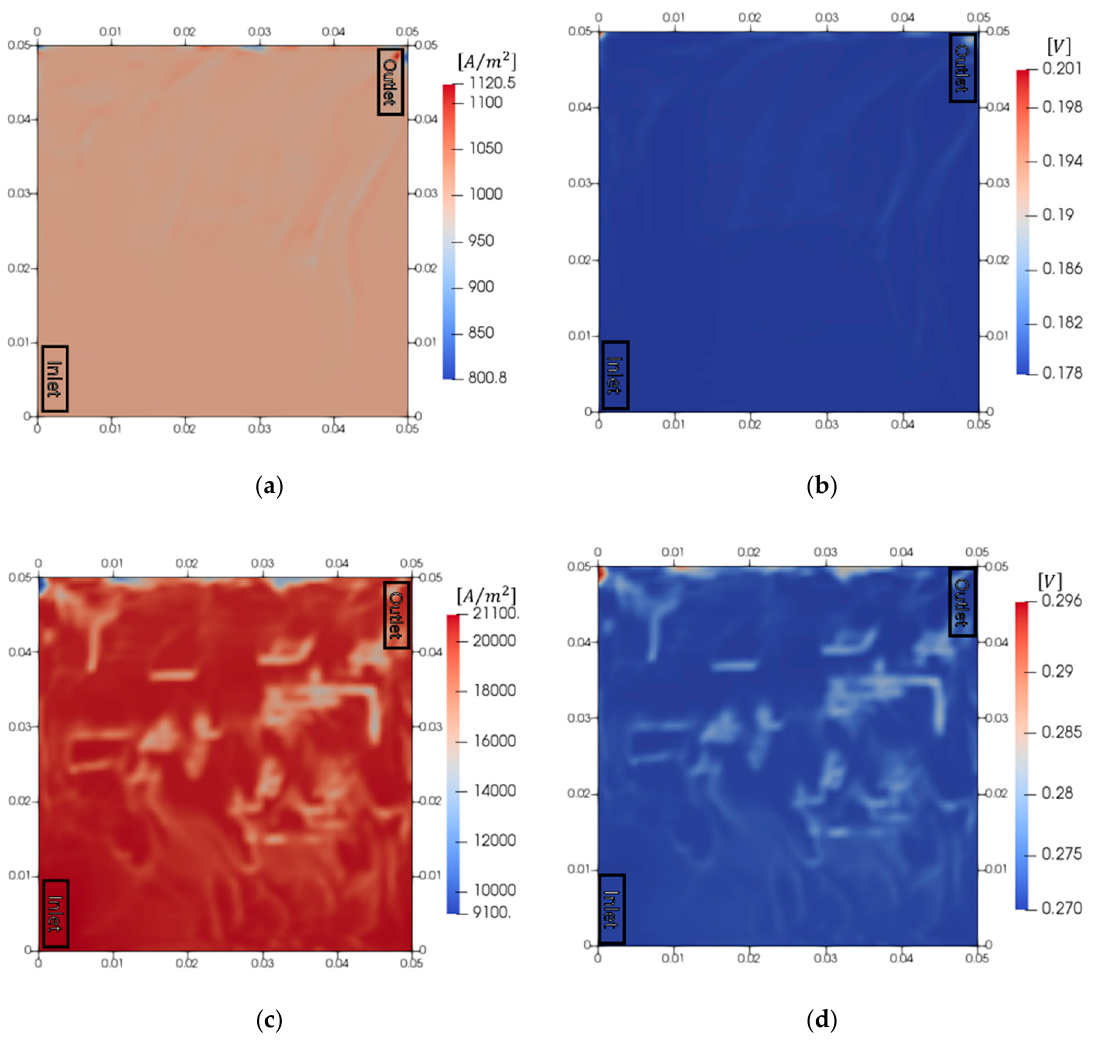
Figure 6. Electrochemical behaviors according to the current density. ( a ) Current density distribution and ( b ) overpotential at a low current density (1000 A / m 2 ), ( c ) current density distribution and ( d ) overpotential at a high current density (20,000 A / m 2 ).